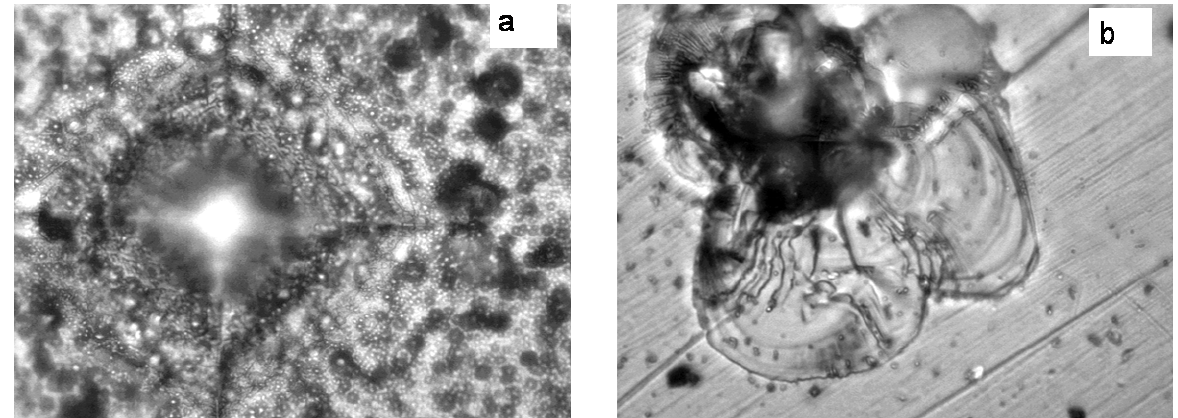
Figure 16: Optical picture of Indent for trilayered SiCN coating (a) and single layer SiCN Coating (b) [183]